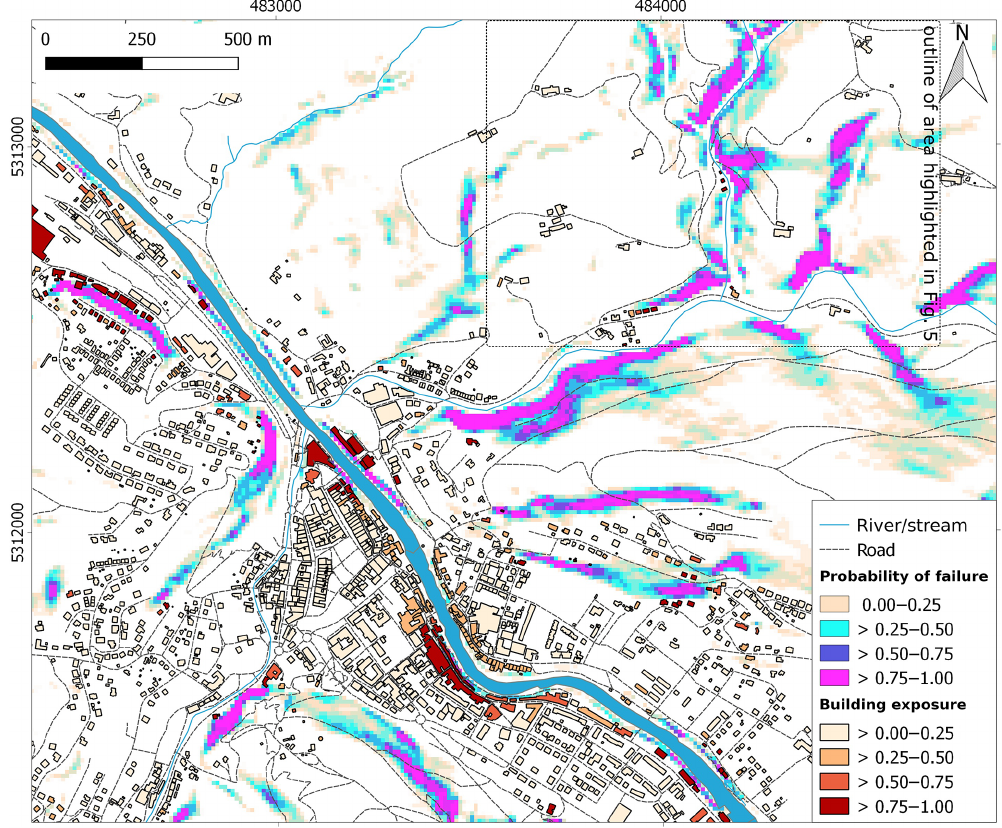
Figure 4. Probability of failure depicted as a proportion of the ensemble members that predict an event to occur (FoS < 1.0). Building exposure to current slope failure predictions adds an additional information layer for decision makers. Buildings and roads are imported from the OSM database (© OpenStreetMap